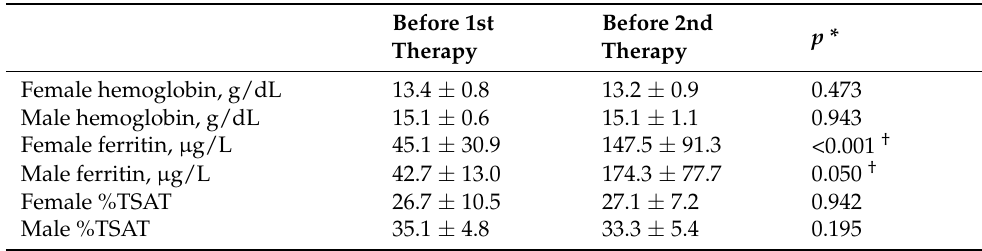
Table 3. Iron characteristics of repeated administration of IV FCM in primary RLS ( n = 26; females = 22, males =